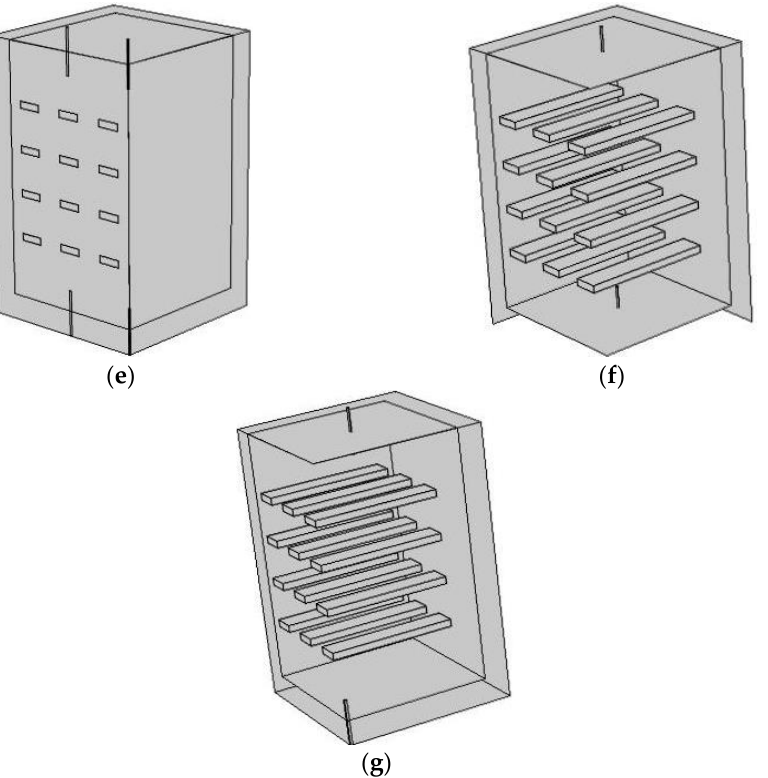
Figure 19. Water distribution scheme: ( a ) one-inlet–one-outlet; ( b ) two-inlets–two-outlets-a; ( c ) two-inlets–two-outlets-b; ( d ) three-inlets–three-outlets; ( e ) three-inlets–three-outlets-b; ( f ) four-in- lets–four-outlet; and ( g ) four-inlets–one-outlet.